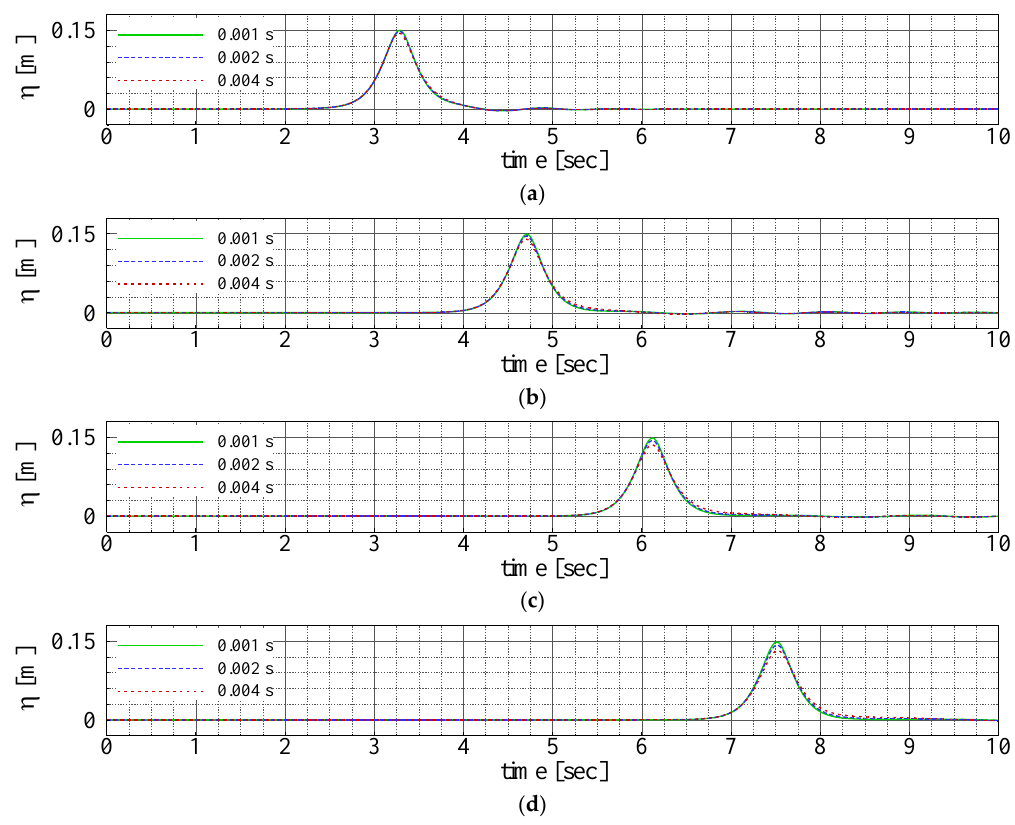
Figure 6. Time step dependency analysis. ( a ) x = 2 m; ( b ) x = 5 m; ( c ) x = 8 m; ( d ) x = 11 m. Table 3. RMSE of the time step dependency analysis.